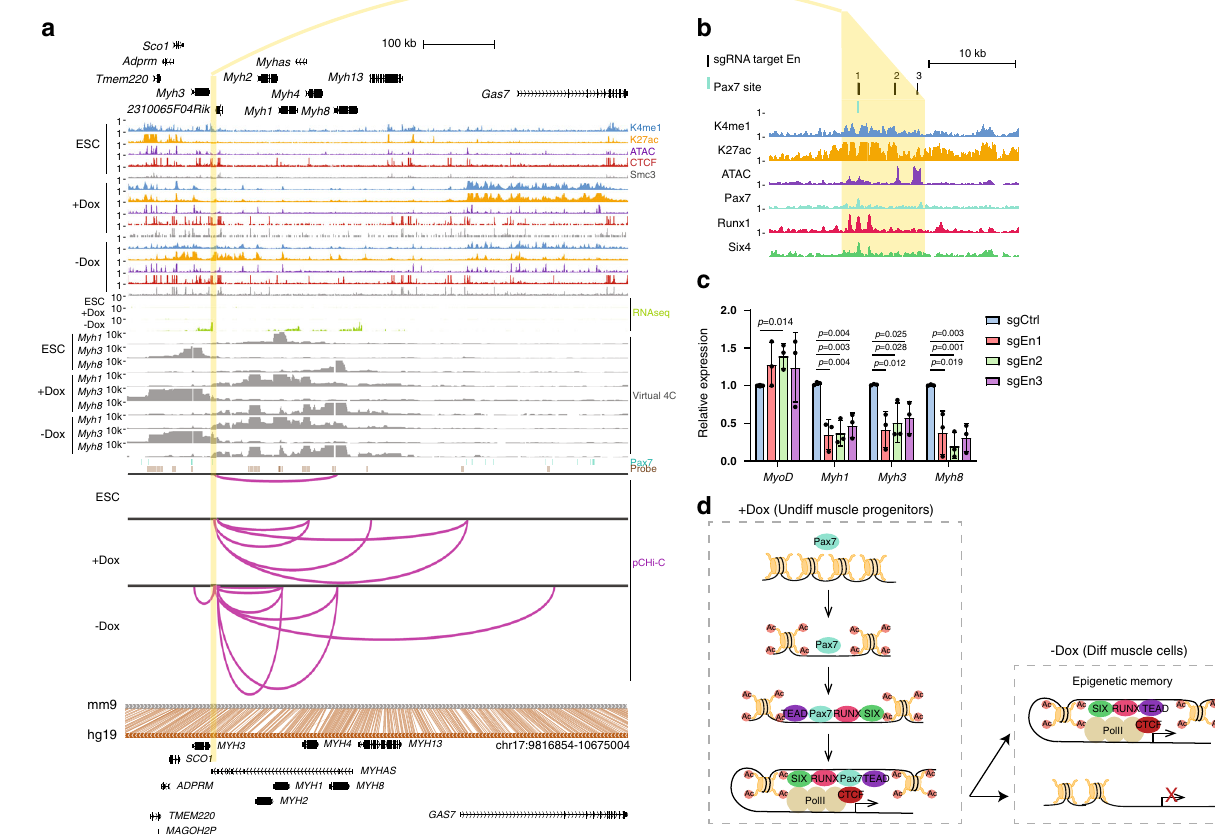
Fig. 7 An EnH in differentiated iPax7 muscle cells regulates expression of three Myh genes. a Genome browser tracks (top) around an EnH (highlighted in yellow) identi fi ed in iPax7 cells within the Myh gene cluster, showing ChIP-seq, ATAC-seq, RNA-seq, Pax7 binding sites, pCHi-C probes, and high- con fi dence pCHi-C interactions (magenta arcs with associated virtual 4C plots) in ESCs and iPax7 cells before ( + Dox) and after ( − Dox) differentiation. Bottom, conservation between mouse (mm9) and human (hg19) genomes. Conserved regions are connected with brown lines between aligned genomes. Below hg19 track is the Refseq annotation for human genes at the conserved regions. b Transcription factor binding at the Myh EnH (yellow). c Relative expression of Myh EnH target genes in differentiated iPax7 cells after CRISPR inhibition (CRISPRi) with three distinct sgRNAs targeting the EnH; n = 3 (biological replicates for each sgRNA). Bars are mean ± s.d., normalized by Gapdh and expressed relative to mean levels of the control sgRNA (sgCtrl). Statistical signi fi cance tested with two-tailed Student ’ s t -test. d A model for the re-organization of Pax7-associated P – En interactions during myogenic differentiation. See text for